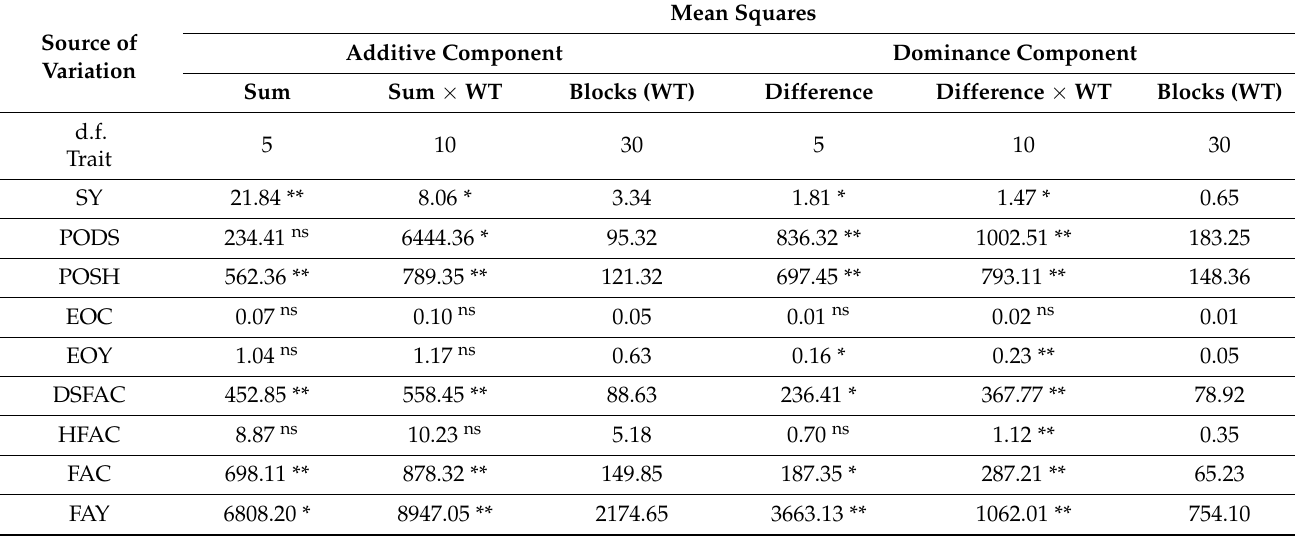
Table 5. Analysis of variance for additive and dominance components and their interactions with water treatments (WT) for different traits in